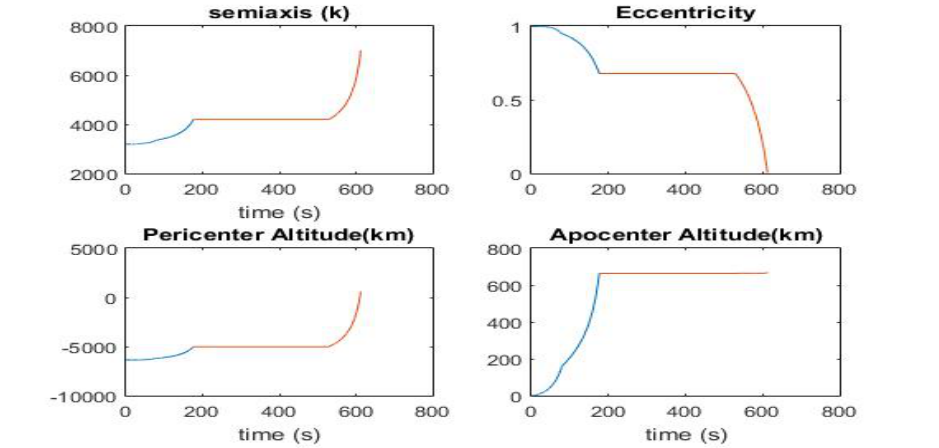
Figure 8. The altitude plot: analytical and numerical results during gravity-turn arc. Numerical altitude of the first and second stage is in black, analytical altitude of the first stage is in the blue line and the second stage in the orange line.